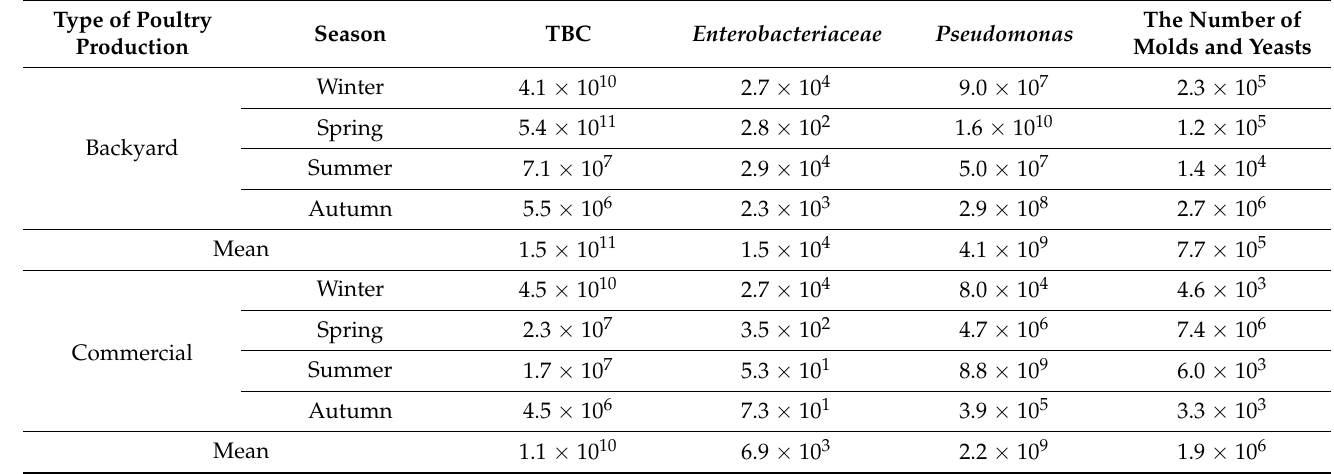
Table 5. Average microbial contamination (CFU/g) of the